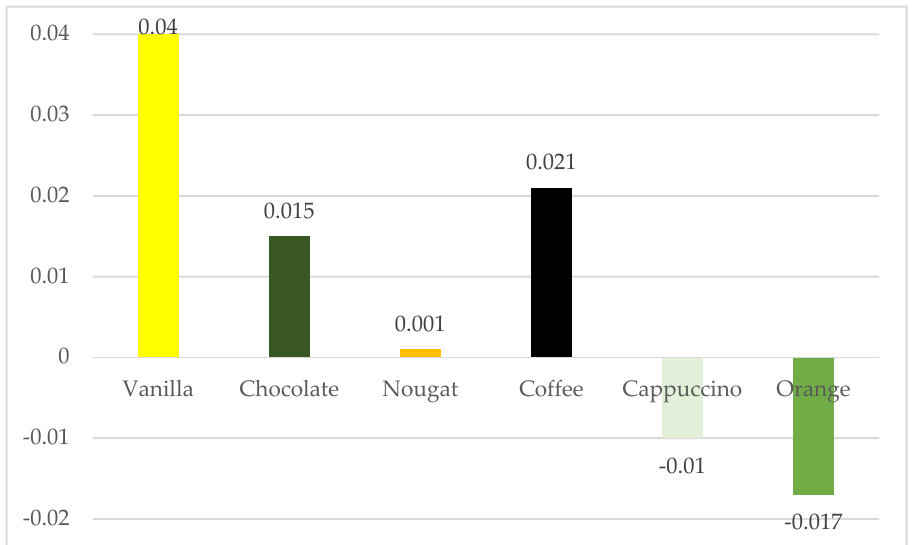
Figure 5. Emotional polarity when recommending aromas for the confectionery department.